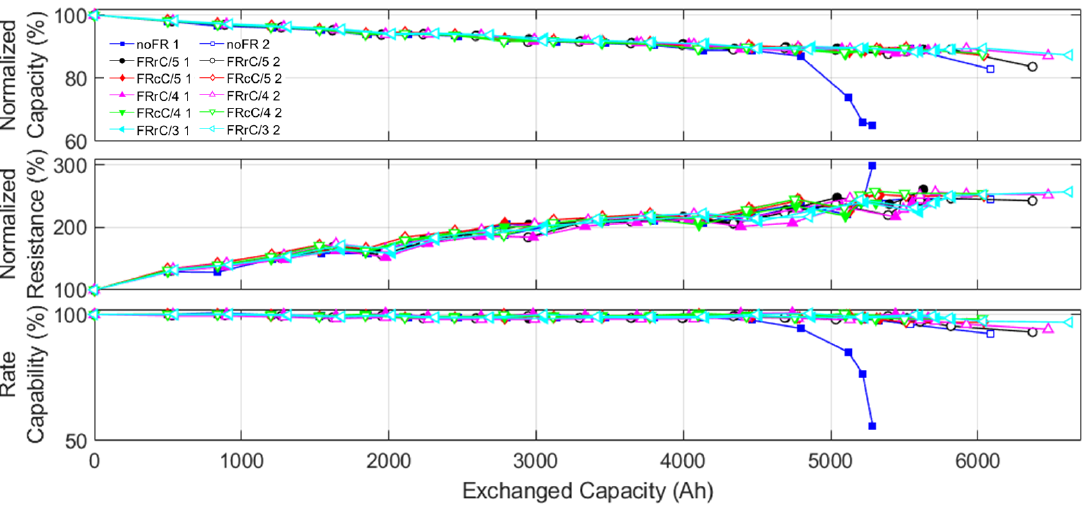
Figure 2. Normalized capacity, resistance, and rate capability versus exchanged capacity.